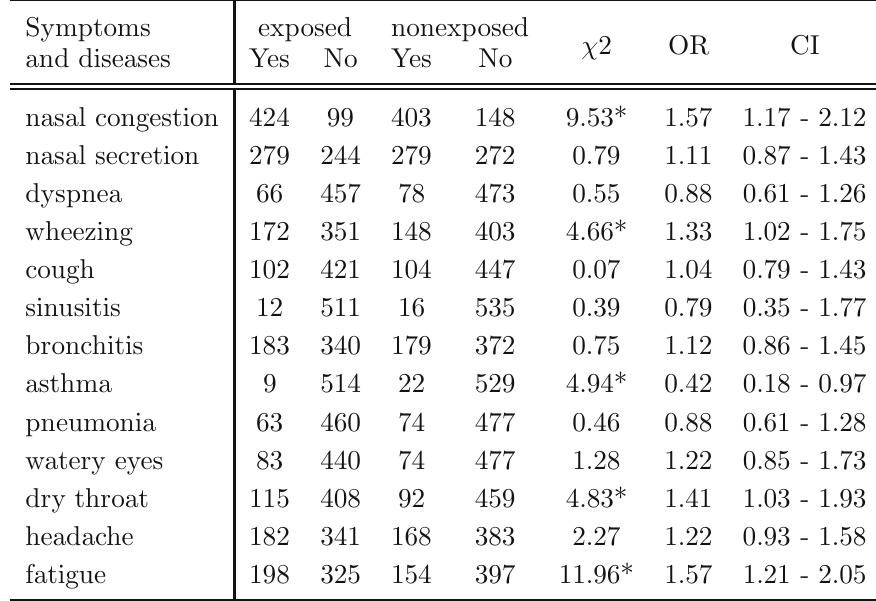
Table 8 Exposure to textile allergens and its influence on children’s